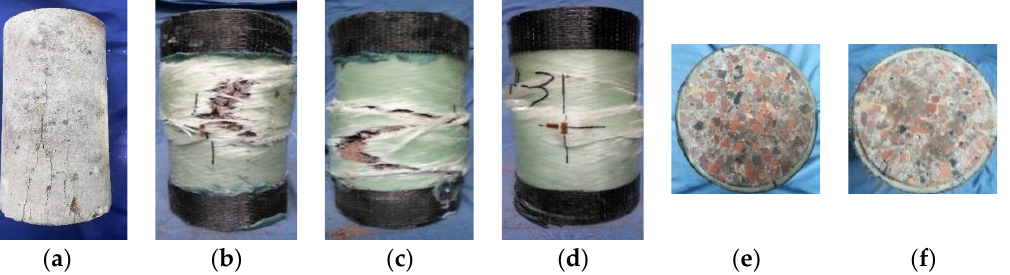
Figure 4. Failure pattern of the specimens. ( a ) T0. ( b ) T3E1. ( c ) T5E1. ( d ) T7W1. ( e ) T5E1 upper surface. ( f ) T7W1 upper surface.